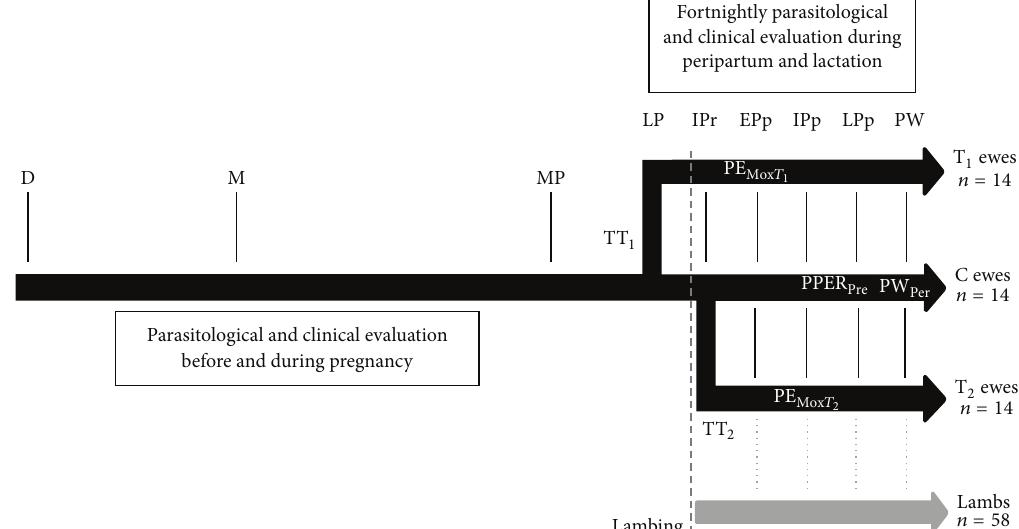
Figure1:Experimentaldesigntodescribeperiparturientnematodeeggrise(PPER)ofewesnaturallyinfectedwithgastrointestinalnematodes and to measure the efficacy and persistency of peripartum strategic treatment with moxidectin (Mox) either at the onset of late pregnancy (TT 1 ) or at the end of immediate peripartum (TT 2 ) period under tropical Andes high altitude conditions. Parasitological and clinical evaluations included FEC by McMaster test, anemia detection by FAMACHA© system, diarrhea assessment by Dag scoring, body weight, and body condition assessment. Fecal egg count reduction (FECR) was employed to test posttreatment moxidectin efficacy 15 days after treatment and PE ), the prevention of PPER at late postpartum (PPER Pre ) period, and preweaning persistency (PW Per ). Ewes in control (PE Mox 𝑇 1 Mox 𝑇 2 group (C) and offspring of all ewes were untreated against gastrointestinal nematodes. D: dry ewes; M: mating; MP: midpregnancy; LP: